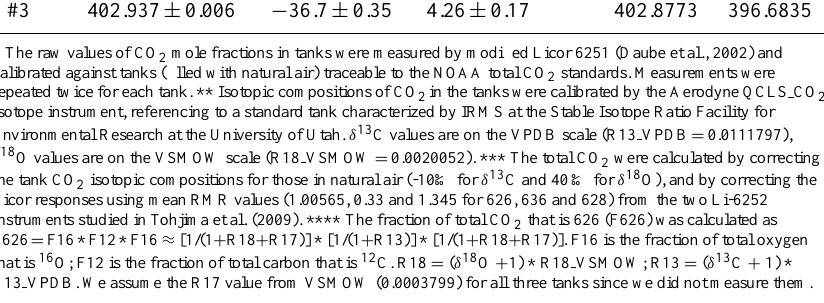
* The raw values of CO 2 mole fractions in tanks were measured by modified Licor 6251 (Daube et al., 2002) and calibrated against tanks (filled with natural air) traceable to the NOAA total CO 2 standards. Measurements were repeated twice for each tank. ** Isotopic compositions of CO 2 in the tanks were calibrated by the Aerodyne QCLS CO 2 isotope instrument, referencing to a standard tank characterized by IRMS at the Stable Isotope Ratio Facility for